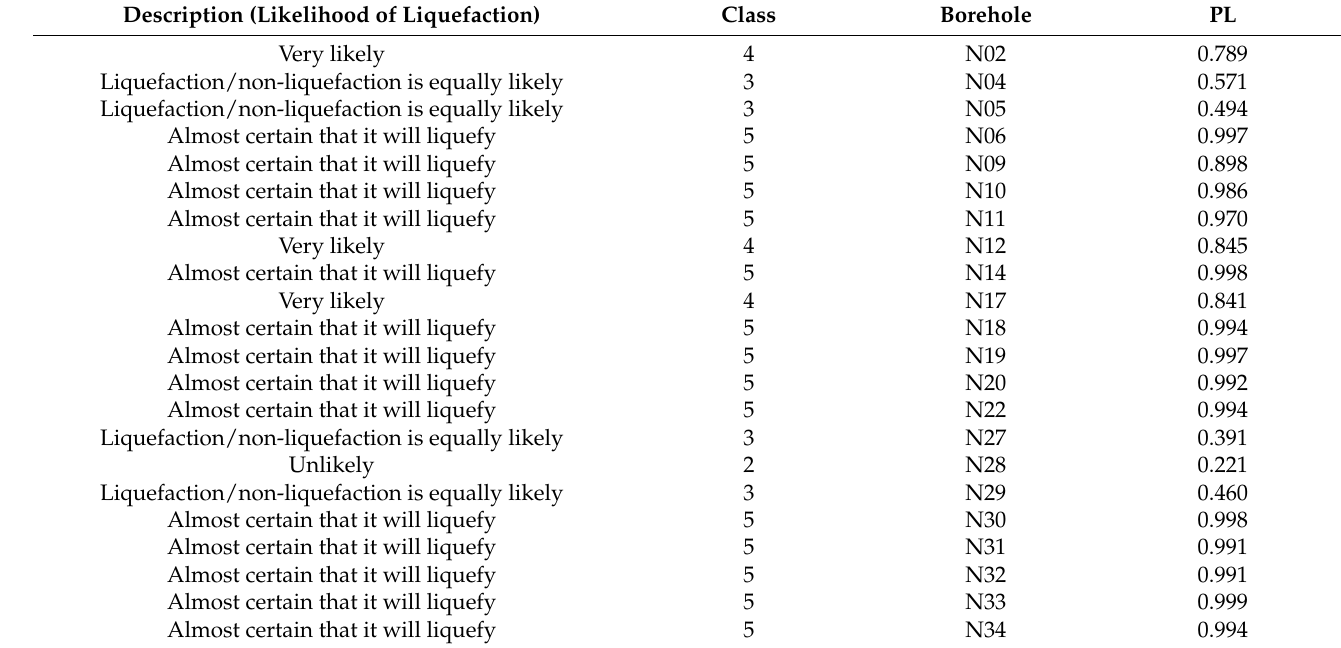
Table 7. Liquefaction probability calculation according to the class proposed by Chen and Juang [38] in the city of Portoviejo.